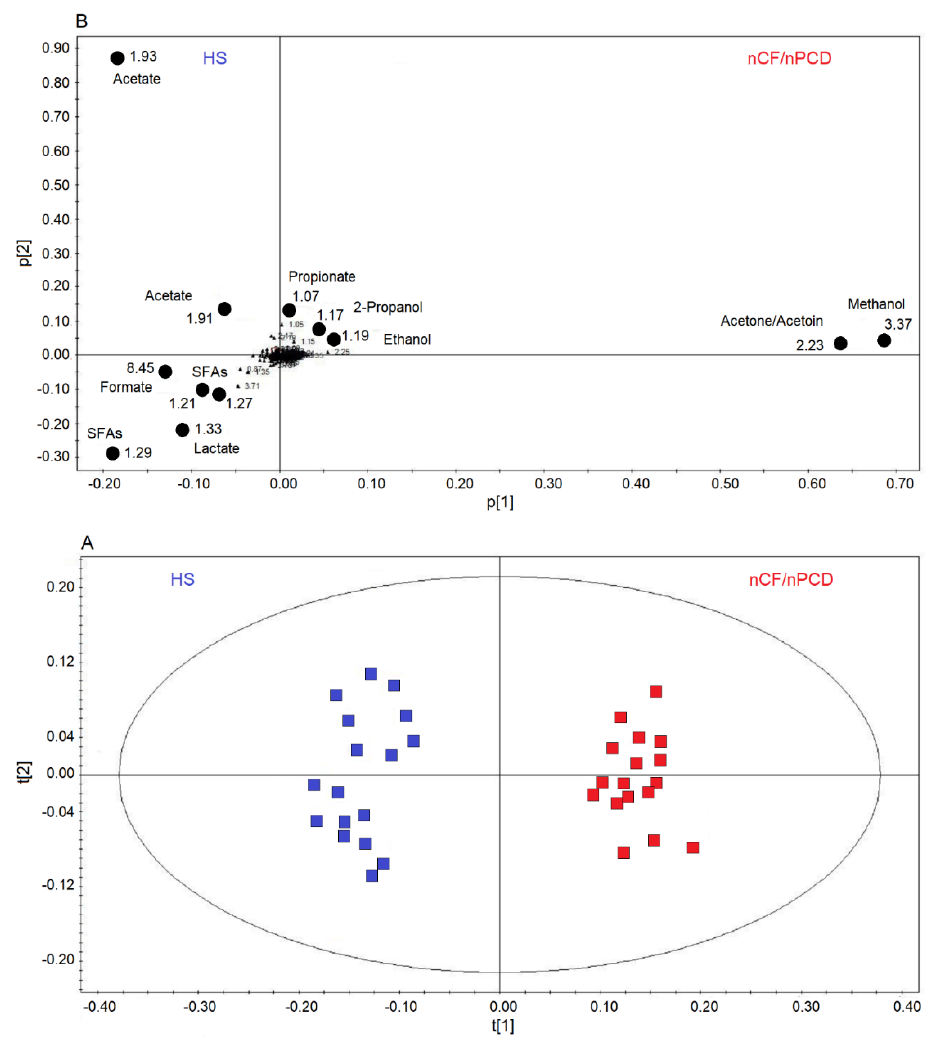
Figure 3. Orthogonal projections to latent structures discriminant analysis (OPLS-DA) of EBC samples for the nCF / nPCD bronchiectasis and healthy subjects (HS) comparison. ( A ) Scores plot showing the degree of separation of the model between nCF / nPCD (red squares) and HS (blue squares). The model presents strong regression (95%, p < 0.0001) and high-quality parameters (R 2 = 85.40% and Q 2 = 88.82%). ( B ) Loadings plot associated with the OPLS-DA analysis, showing the metabolites responsible for the between-class separation. Numbers refer to buckets’ chemical shifts (i.e., spectral positions), and the discriminating metabolites are explicitly labeled by black dots. The pq[1] and pq[2] values refer to the weight that combines the X and Y loadings (p and q).